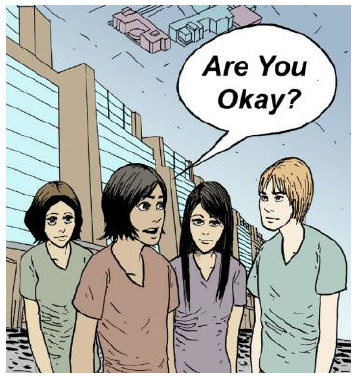
Figure 1. Front Cover of Are You Ok?